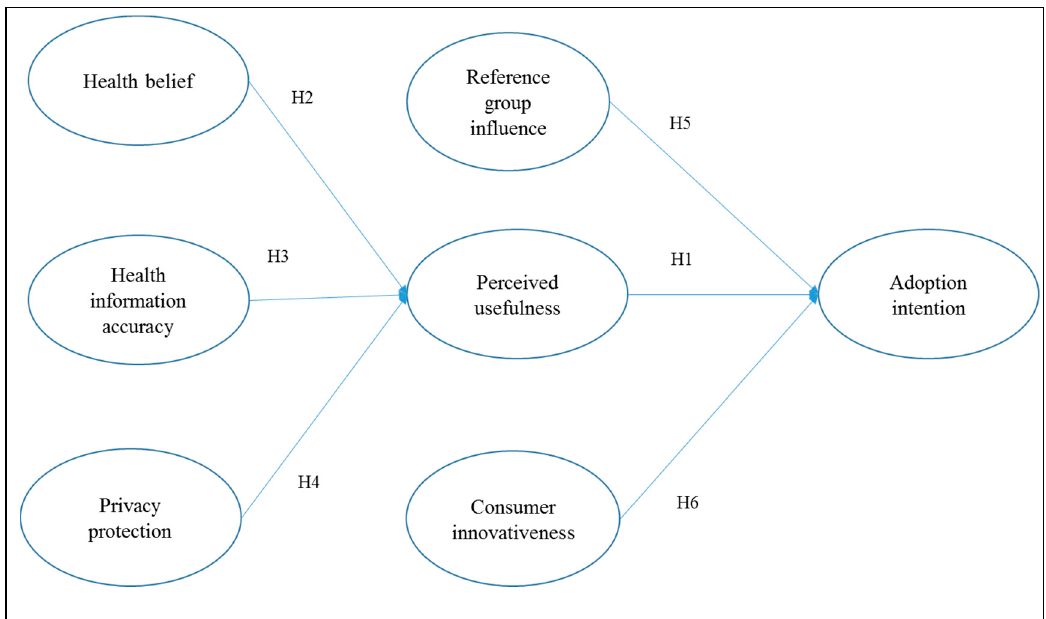
Figure 1. Research model.